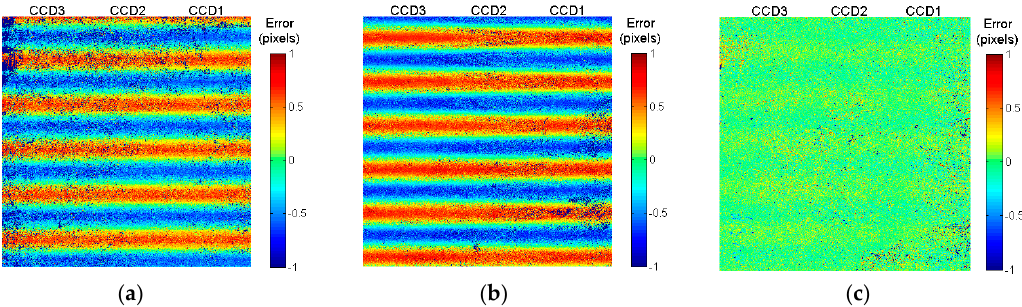
Figure 12. Parallax images across the track between B2 and B3 of ( a ) Scene A, ( b ) Scene B, and ( c ) Scene C.